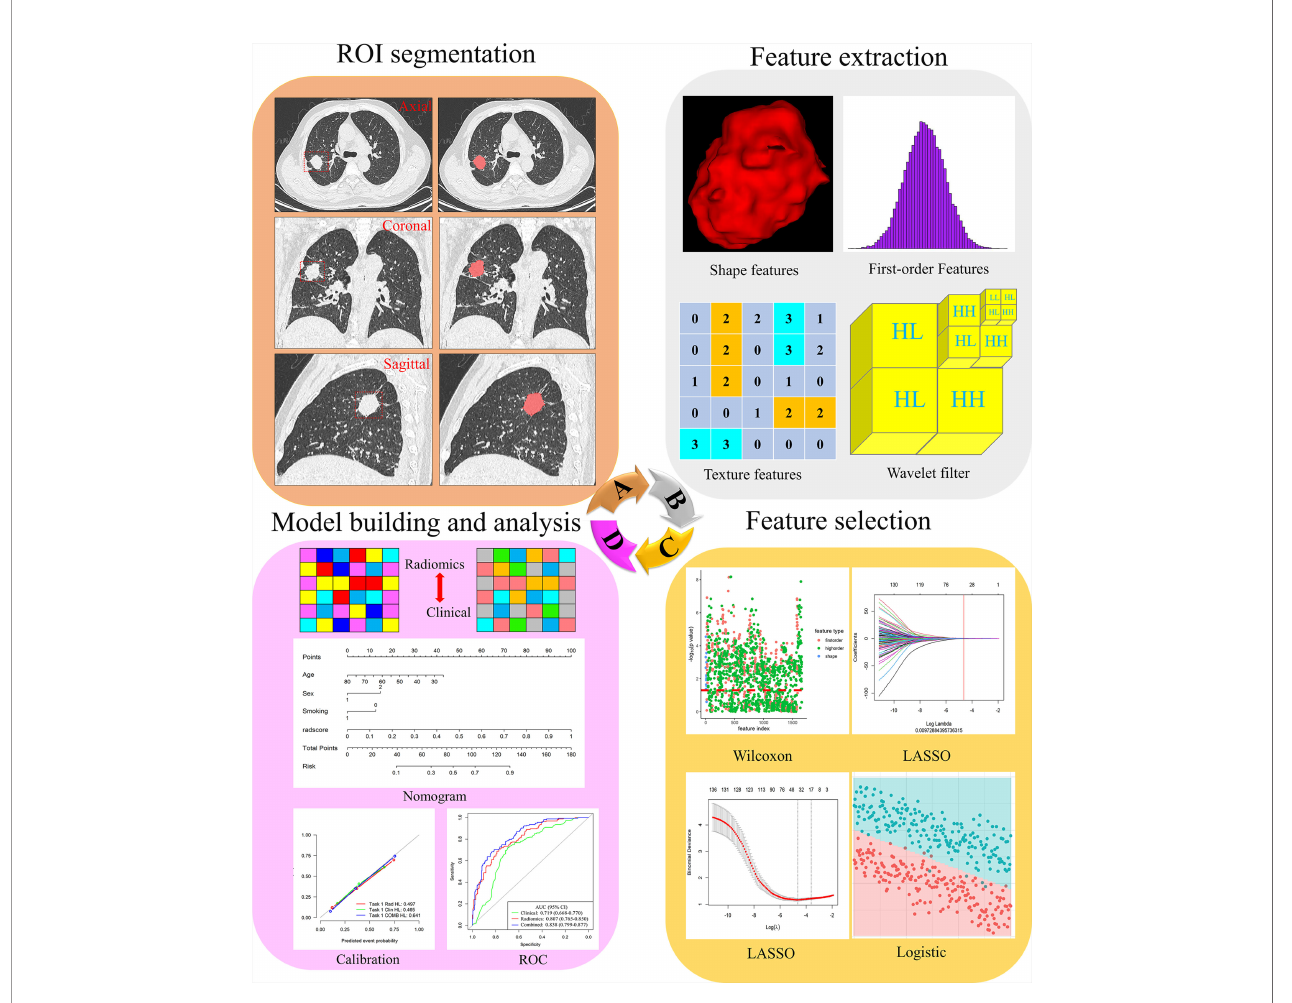
FIGURE 2 | Flowchart of the process of radiomics. (A) The tumours were segmented on CT images to form the region of interest (ROI). (B) Radiomics feature extraction from the ROI. (C) Radiomics feature dimensionality reduction process. (D) Construct a radiomics